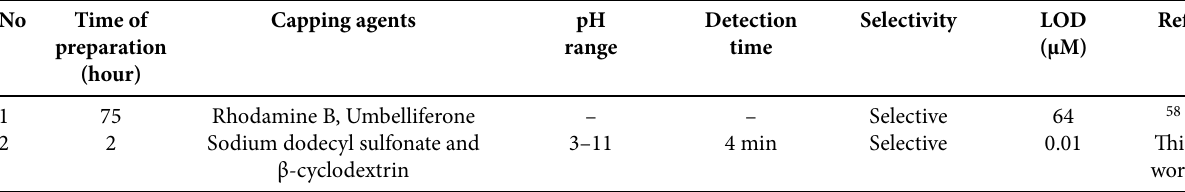
Table 2. Comparison of colorimetric sensing probe for Cr 2+